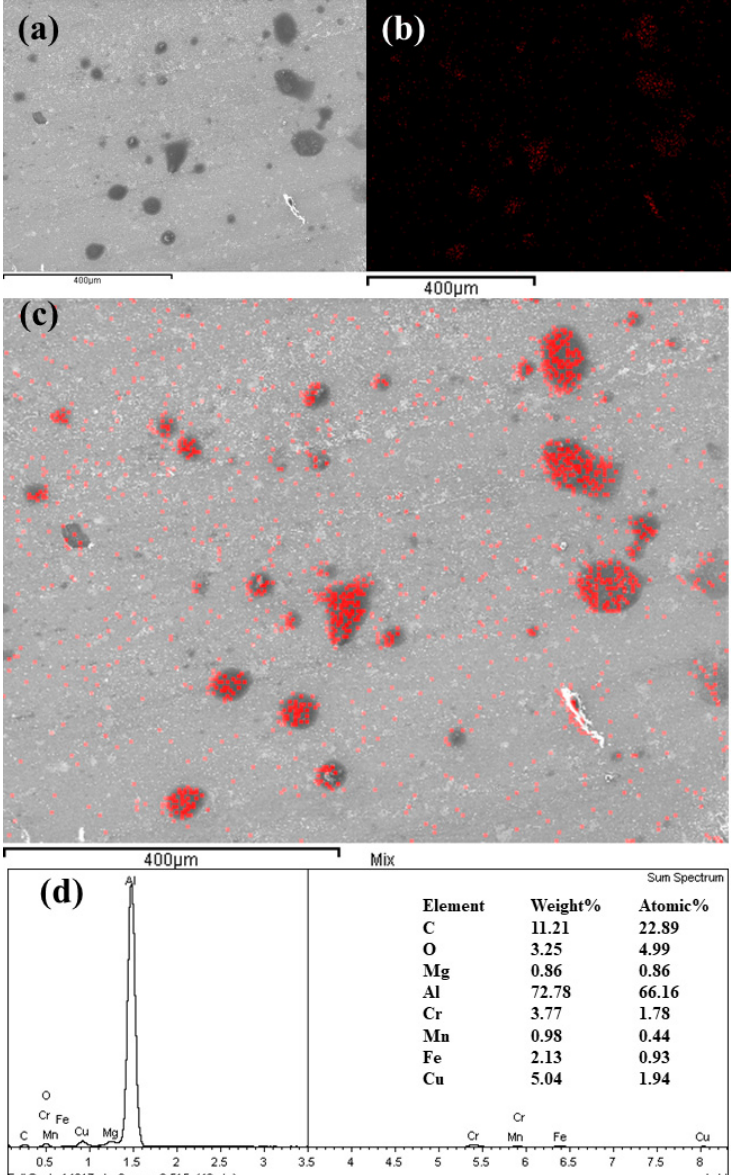
Figure 15. SEM image and elemental mapping for the surfaces tested with 0.20 vol.% nanolubricant at 20 N ( a ) and its material composition, using EDX ( b – d ).